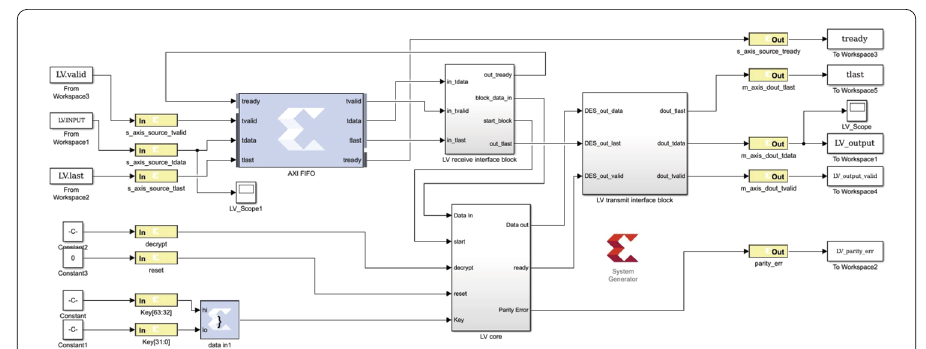
Figure 1 The system of the LV model-based FPGA